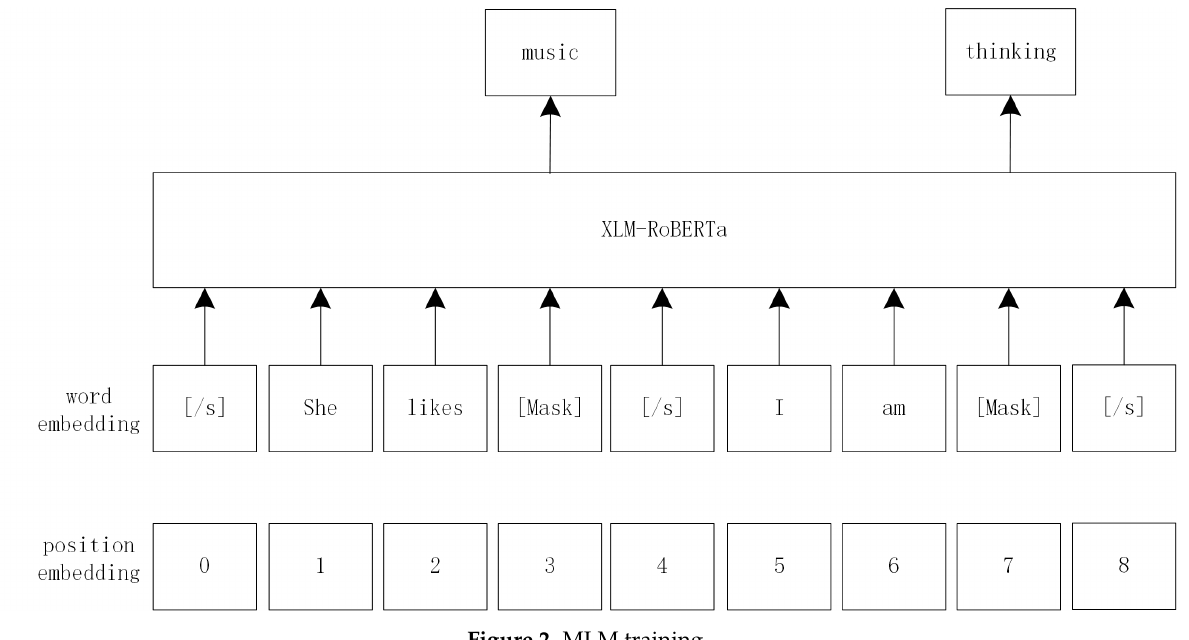
Figure 2. MLM training.